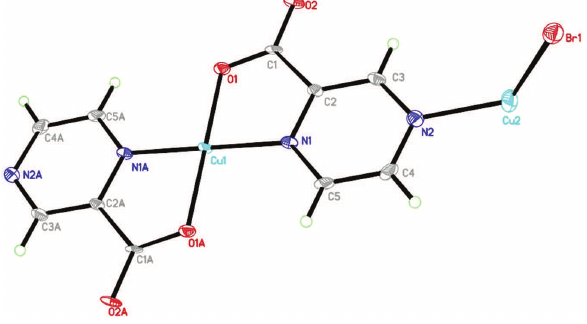
Table 1: Data collection and handling.